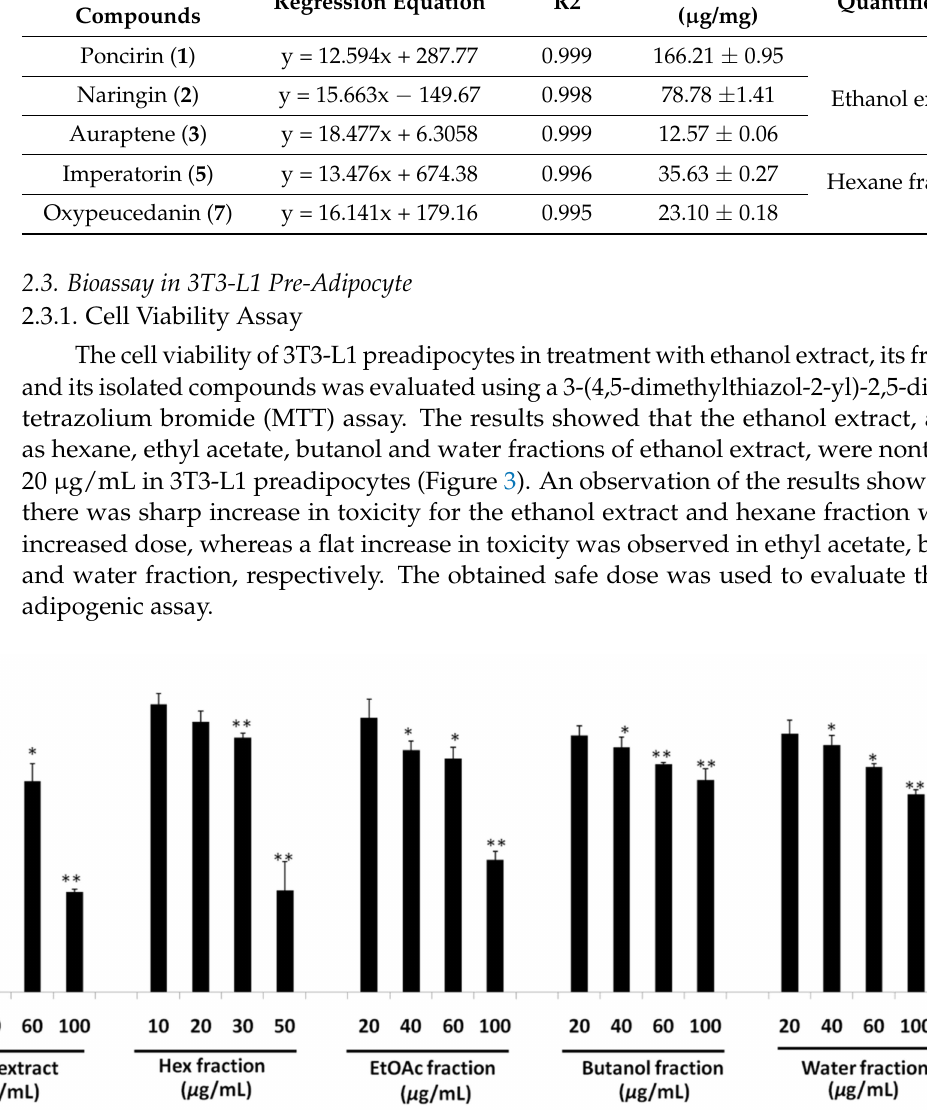
Figure 3. Cell viability of 3T3-L1 cell line on treatment with ethanol extracts, hexane fraction, ethyl acetate fraction, butanol fraction and water fraction of the Ponciri Fructus. Each set of data represents mean of triplicate experiment ± standard deviation. Significant difference between the groups was calculated using two-tailed Student’s t -test. * p < 0.05 vs. control, ** p < 0.01 vs. control are used to represent significant difference in cell viability of the extract sample compared to non-treated control